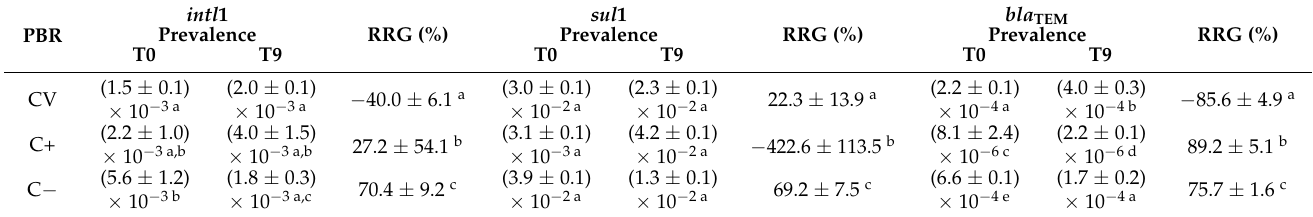
Table 4. Relative abundance (prevalence) of intl 1 and resistance genes ( sul 1 and bla TEM ) at the beginning (T0) and at the end (T9) of the experiment, and percentage of the reduction of resistance genes after the treatment (RRG), determined for each PBR. For each gene, values (average ± standard deviation) with the same superscript letters are not statistically different ( p < 0.05). sul 1 bla TEM Prevalence RRG (%) Prevalence RRG (%) Prevalence RRG (%) T0